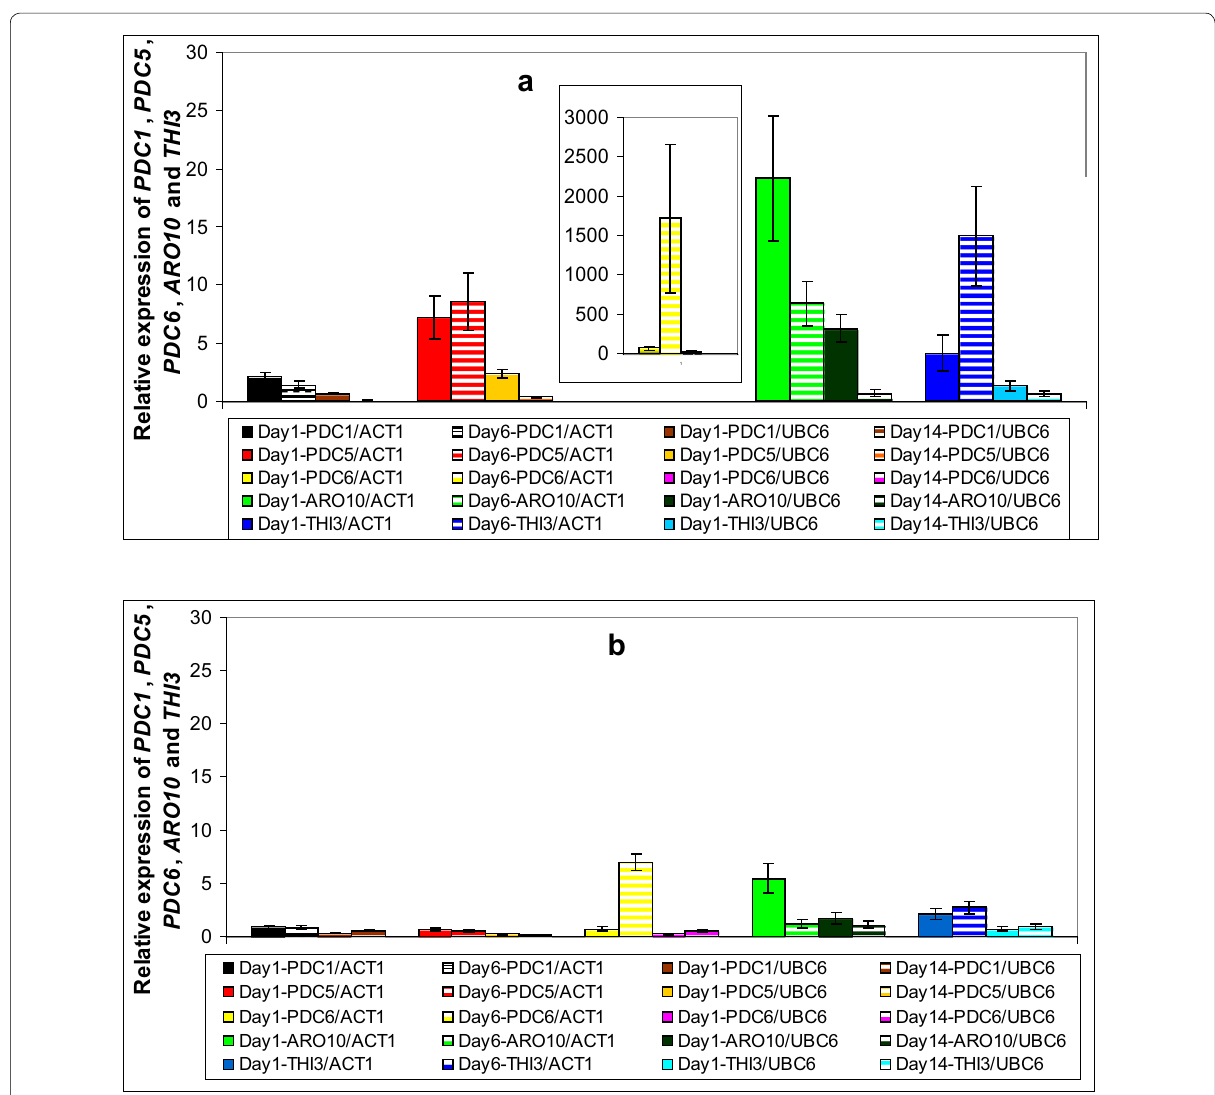
Fig. 3 Expression of genes PDC1, PDC5, PDC6, ARO10 and THI3 during Debina must fermentations. a Strain VL1 and b strain Z622. In a and b : gene expression on day 1 was normalized against the expression levels of both ACT1 and UBC6 genes, whereas: (i) on day 6 expression values were normalized against ACT1 and (ii) on day 14 against UBC6. In each set of values, the first bar corresponds to day 1 normalized against ACT1 , second bar to day 6 normalized against ACT1, third bar to day 1 normalized against UBC6 and fourth bar to day 14 normalized against